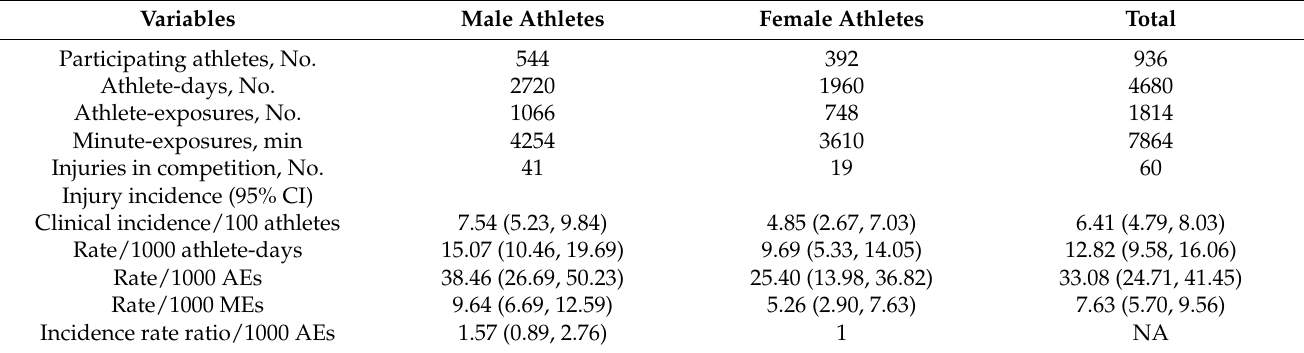
Table 1. Injury rates at the 2019 World Taekwondo Championships in Manchester, United